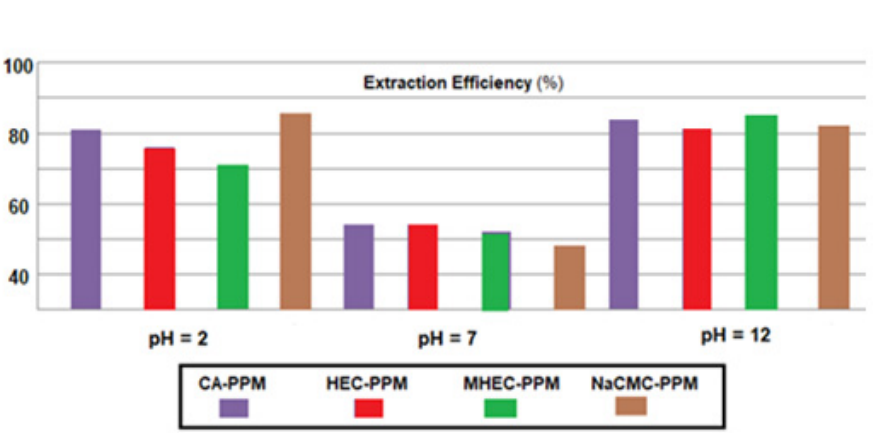
Figure 17. The phenylalanine extraction efficiency EE (%) variation versus the pH of the source phase (SP) for the prepared membranes.